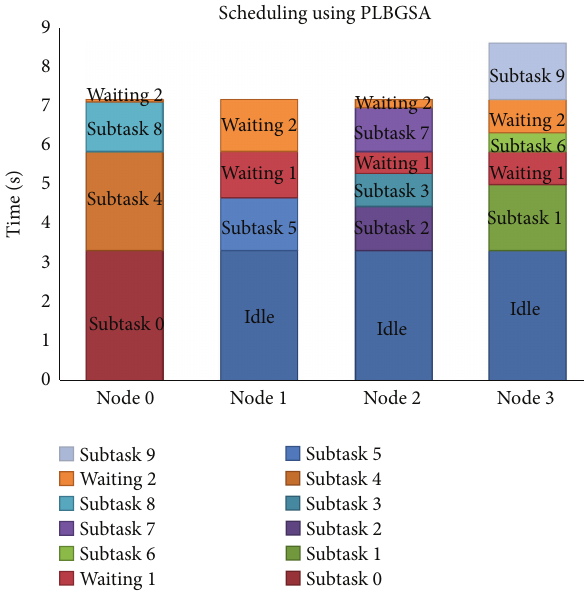
Figure 8: Detailed timewise schedule for all subtasks of DAG based task 𝑡 using PLBGSA.